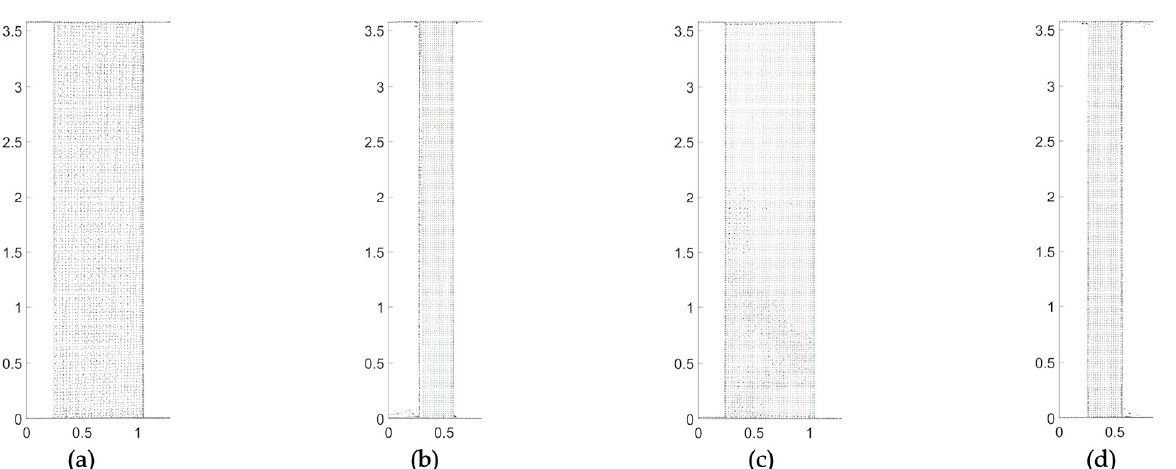
Figure 10. Result of laser scanning, point cloud-column no. 2.: ( a ) plane oriented in the direction of + x -axis, ( b ) plane oriented in the direction of + y -axis, ( c ) plane oriented in the direction of − x -axis, ( d ) plane oriented in the direction of − y -axis.